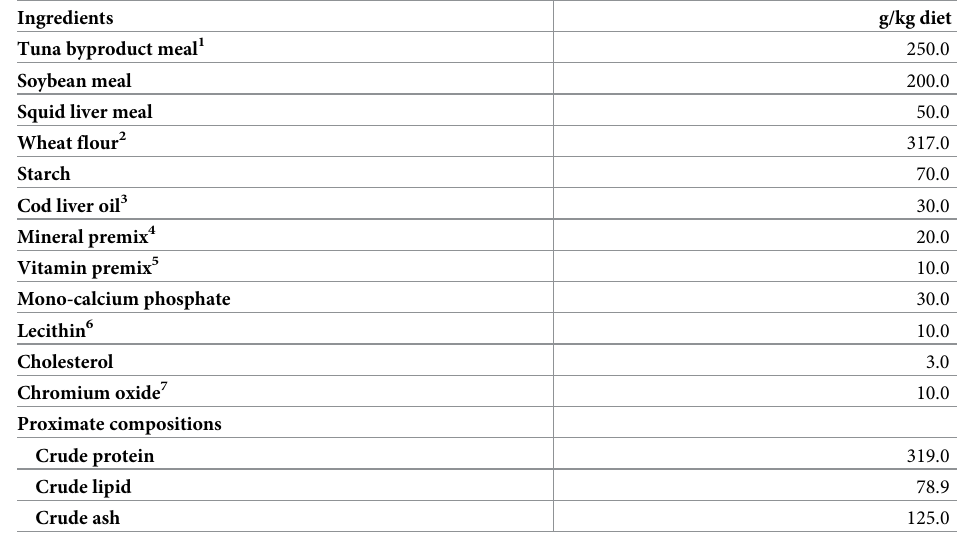
Table 2. Dietary formulation and proximate composition of the reference diet (g/kg, dry matter) for the digest- ibility test of Pacific white shrimp ( Litopenaeus vannamei